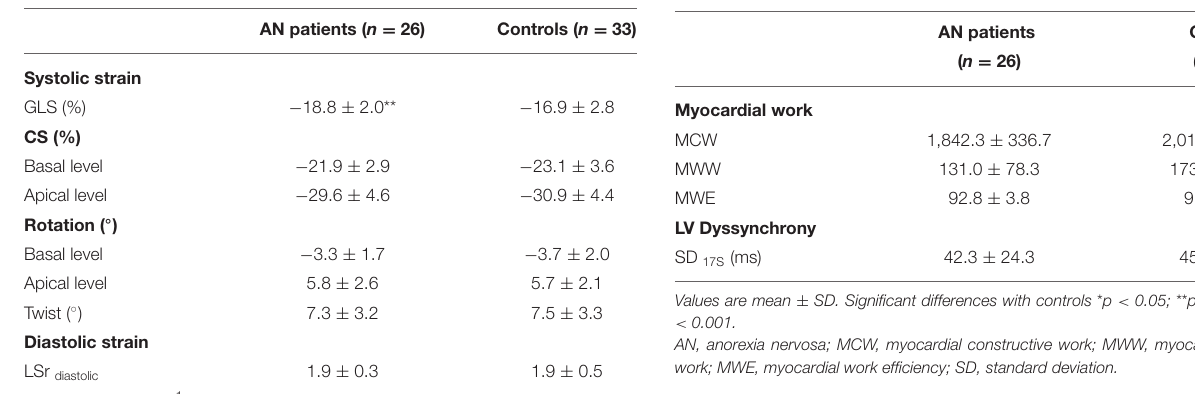
TABLE 4 | LV dyssynchrony assessed by LV strains and myocardial work in AN patients and